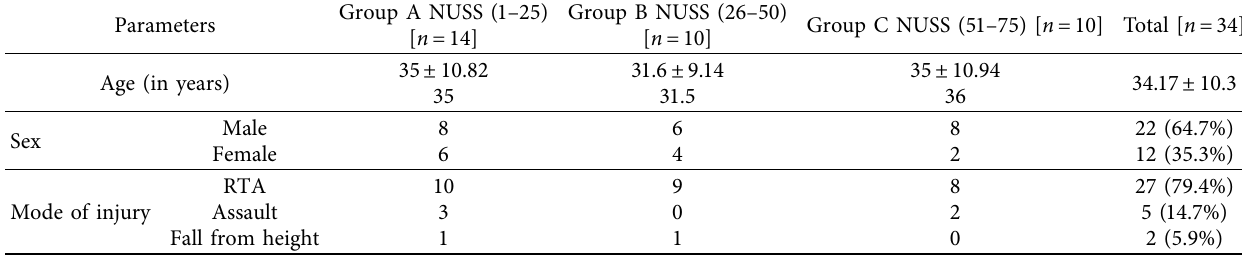
Table 1: Demographic details of the study population.